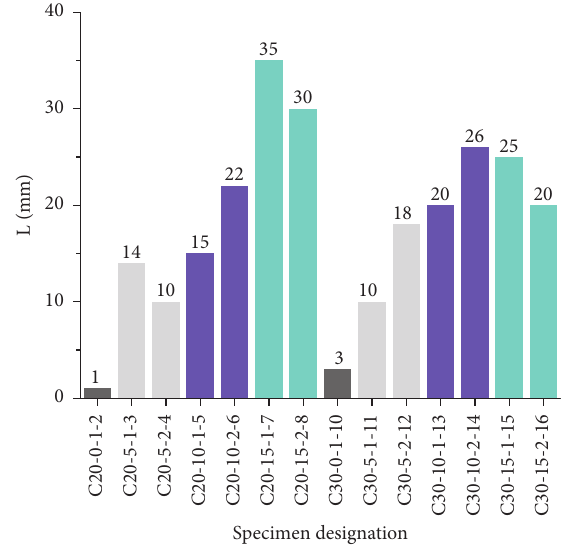
Figure 5: Influence of CAM thickness on CFRP breakpoint